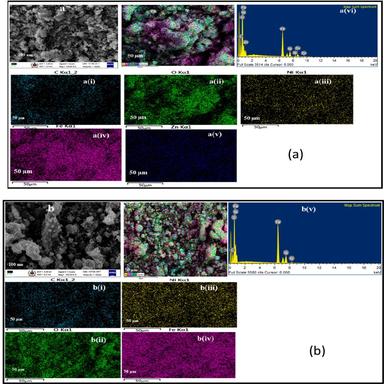
FESEM micrograph along with the elemental mapping of: a) ZNF(HP), b) NF and c) ZF.,.